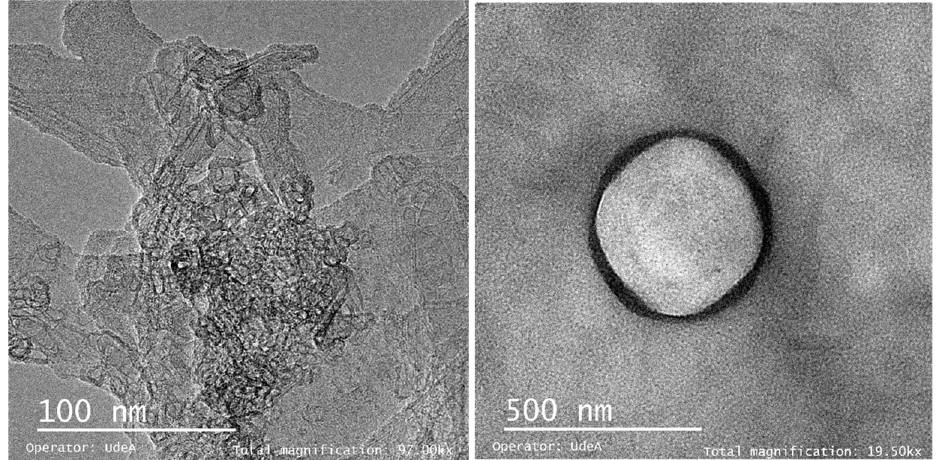
Figure 3. Microcapsule TEM micrograph.